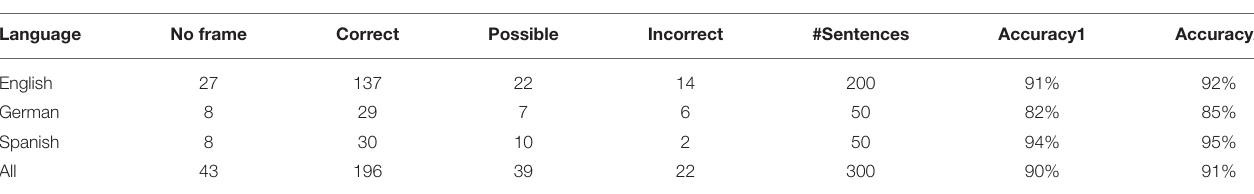
TABLE 3 | Manual evaluation of large ontology multilingual extraction (LOME) 9